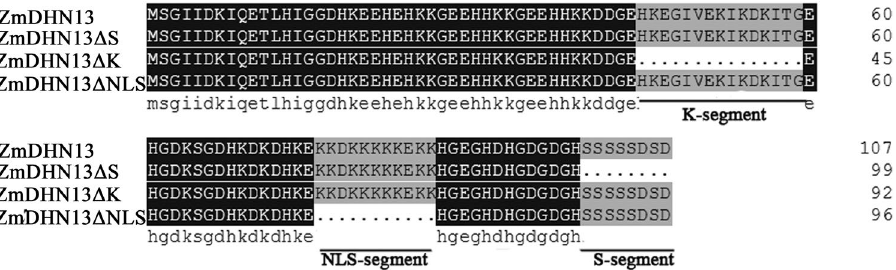
Figure 4. Comparison of the amino acid sequences of ZmDHN13 and the deletion mutants (ZmDHN13 Δ S, ZmDHN13 Δ K, and ZmDHN13 Δ NLS). The conserved segments are shown as indicated.